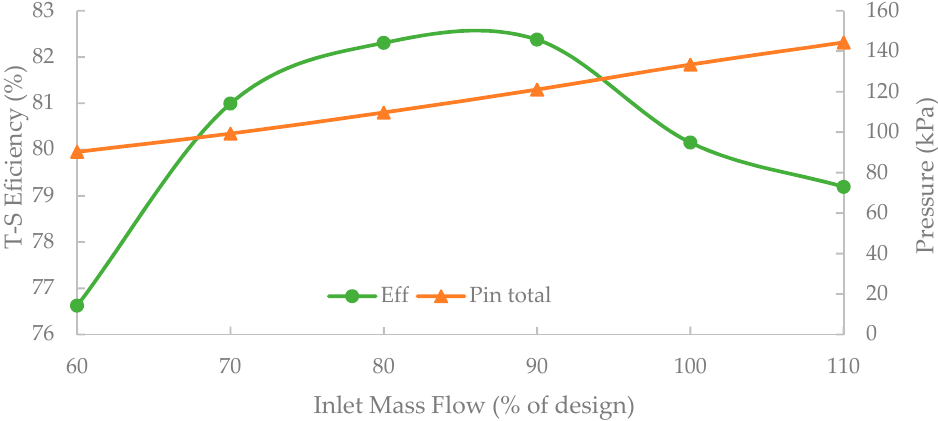
Figure 7. Evolution of the total-to-static turbine efficiency and inlet pressure at varying inlet mass flow rates.